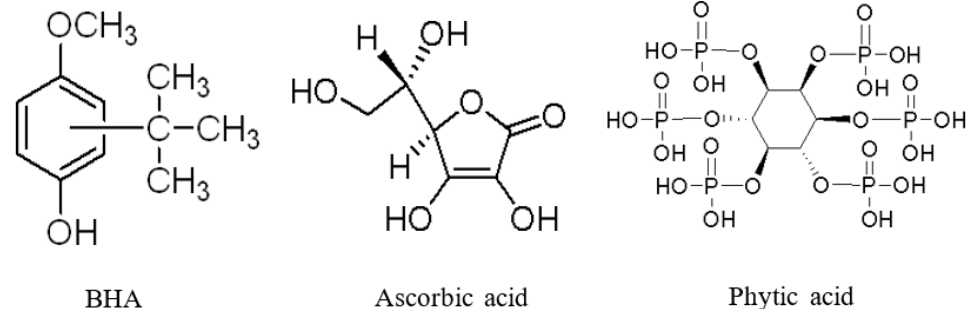
Figure 1. Chemical structures of antioxidants used in our study.